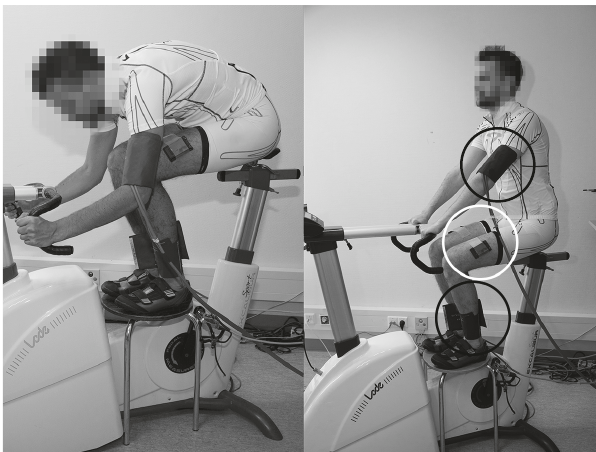
Figure 1: Visual presentation of the used postures (CP and NP for the left and right picture, resp.). This was also the racing position during cycling. In the photographs, the position in recovery is illustratedwhenmeasuringABI(blackcirclesdenotestheplacement of the blood pressure cuffs while the white circle denotes the NIRS devices without the black cloth in order to expose the measurement device in this